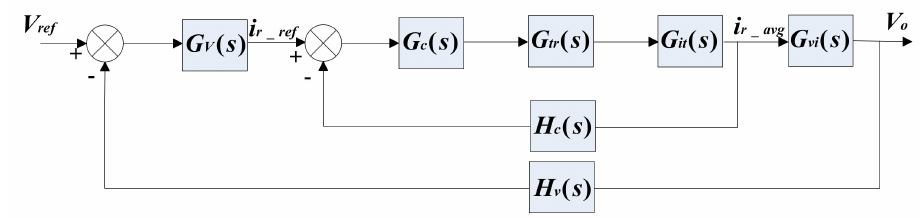
Figure 11. Double closed-loop control block